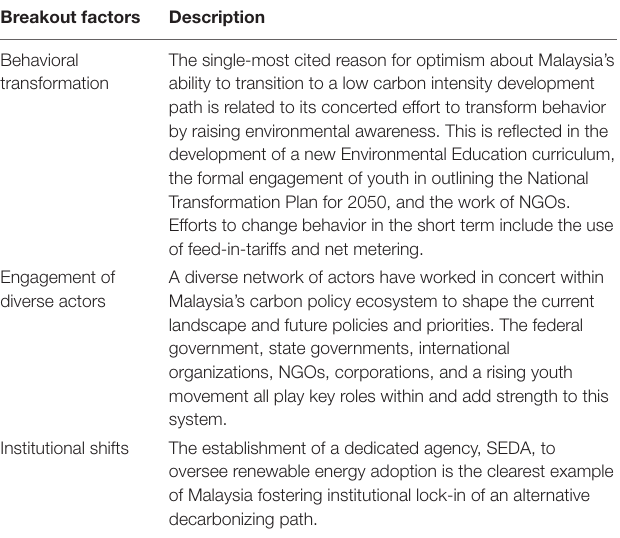
TABLE 4 | Malaysia’s breakout factors from carbon